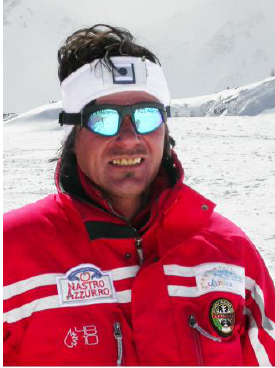
Figure 7. Skiing instructor at La Thuile-Les Suches ski field (45.7° N, 6.6° E, 2100 m a.s.l.), wearing PSF badge at the headband [140].